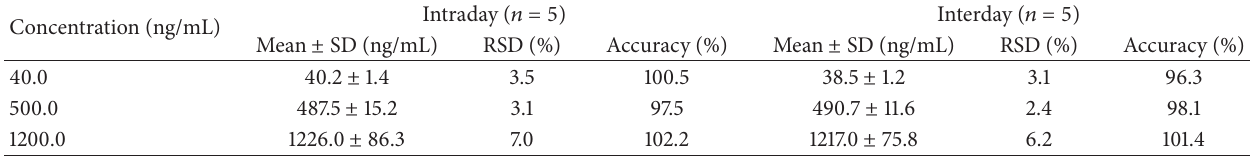
Table 3: Intraday ( 𝑛 = 5 ) and interday ( 𝑛 = 5 ) precision and accuracy for assay of aesculin in rat plasma. Concentration